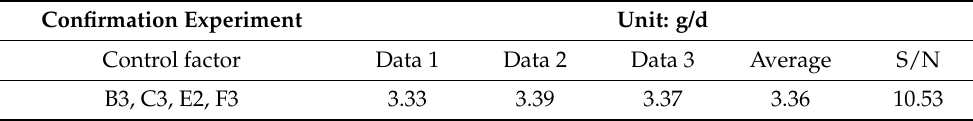
Table 10. The confirmation experiment of the tensile strength. Confirmation